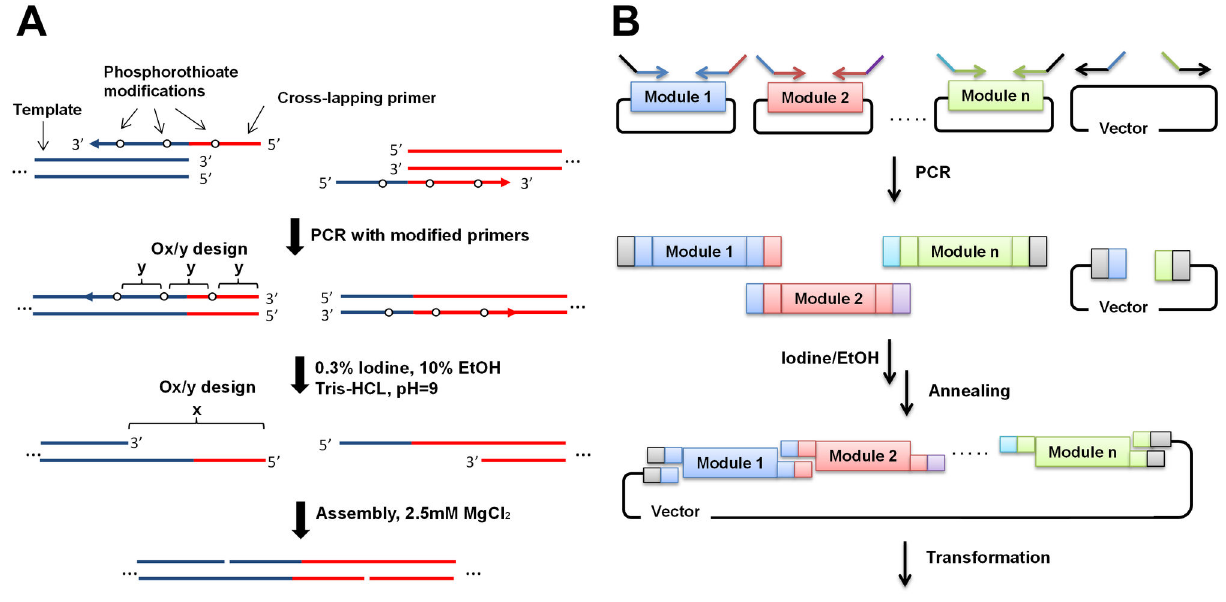
Figure 1. Assembly of DXP pathway. (A) The dxp pathway and Fe-S cluster assembling pathway. GA3P: glyceraldehyde 3- phosphate, DXP: 1-deoxy-D-xylulose 5-phosphate, MEP: 2C-methyl-D-erythritol 4-phosphate, CDP-ME: 4-diphosphocytidyl-2C- methyl D-erythritol, CDP-MEP: 4-diphosphocytidyl-2C-methyl D-erythritol 2-phosphate, MEC: 2C-methyl-D-erythritol 2,4- diphosphate, HMBPP: hydroxylmethylbutenyl diphosphate, IPP: Isopentenyl pyrophosphate, DMAPP: Dimethylallyl pyrophosphate, GPP: Geranyl diphosphate, FPP: Farnesyl diphosphate, GGPP: Geranylgeranyl diphosphate. (B) Illustration of various modules assembled in the project (correlated to Table S3). CAM: chloramphenicol resistance gene, p15A-ori: p15A original of replication. doi: